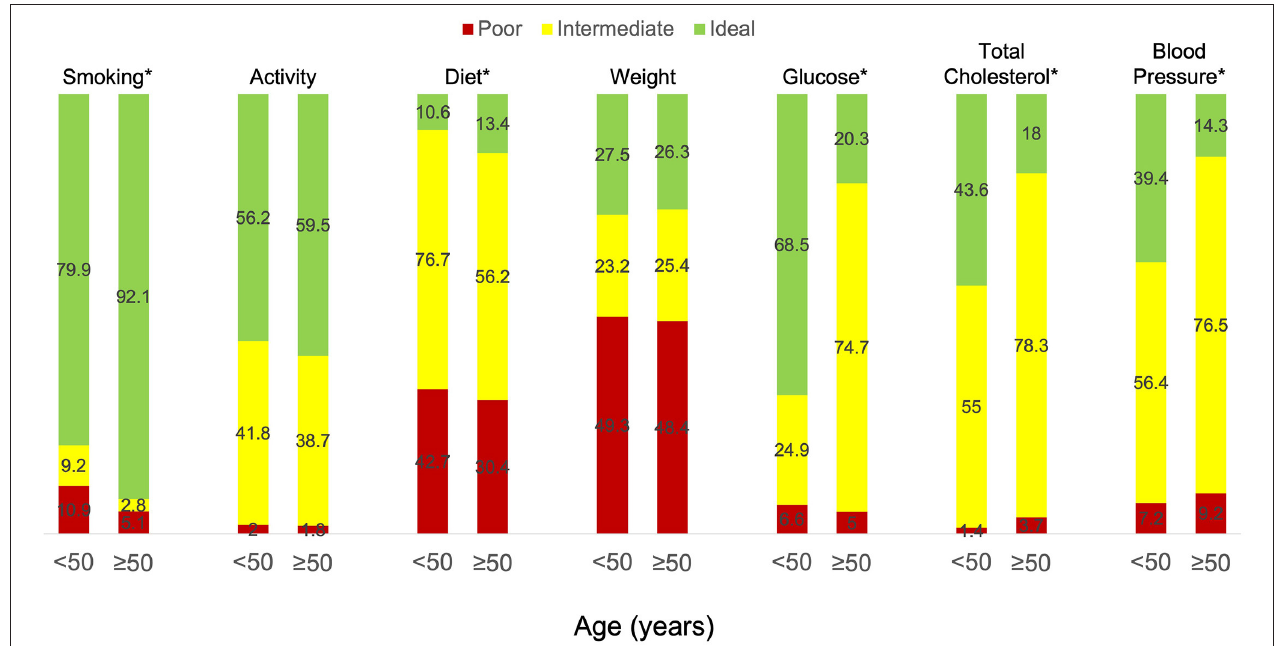
FIGURE 2 | Life’s Simple 7 health factors and behaviors in participants with cardiovascular disease aged < 50 vs. ≥ 50 years old. Individuals received a score of poor, intermediate, or ideal for each of the Life’s Simple 7 health factor and behaviors categories based on criteria outlined by a panel of experts. Results for young adults (age < 50 years) with established cardiovascular disease ( n = 349) are compared to those for older adults (age ≥ 50 years) with cardiovascular disease ( n = 217). * p < 0.01 by Wilcoxon rank-sum